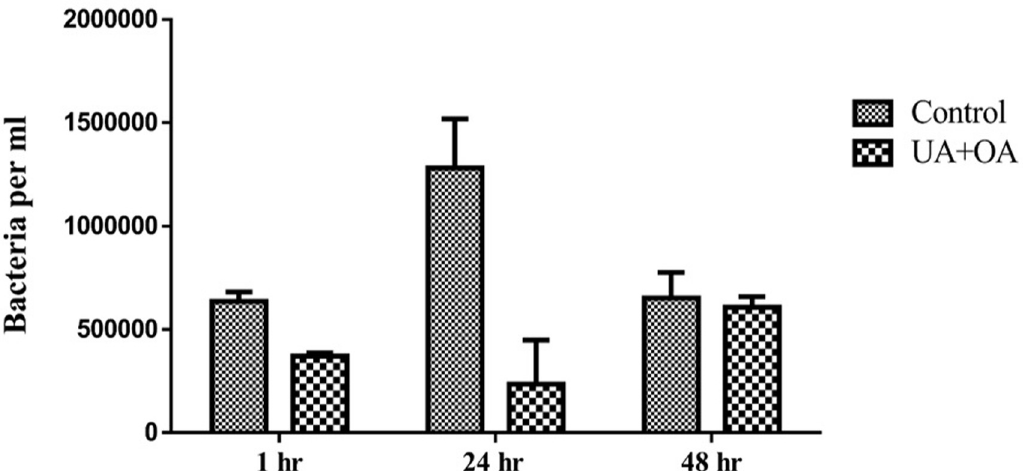
Fig 1. In-vitro anti-tuberculosis activity of UA and OA using H 37 Rv strain. MH-S cells infected with the H 37 Rv strain showed lower bacterial load at 1 and 24 h when treated with UA and OA compared to the control (Isoniazid treated). The values are expressed as mean ± SD, n =